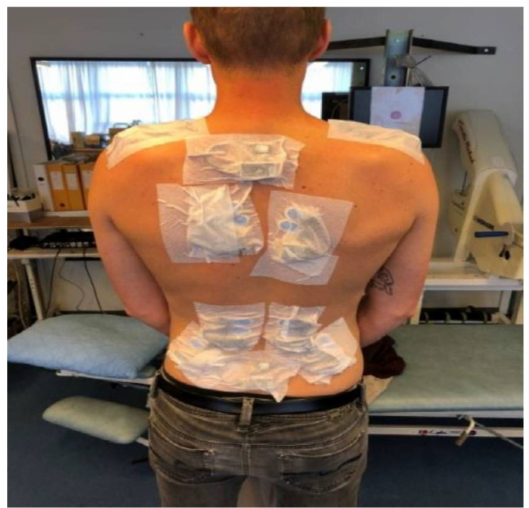
Figure 2. Example of placement of sEMG electrodes fixated with